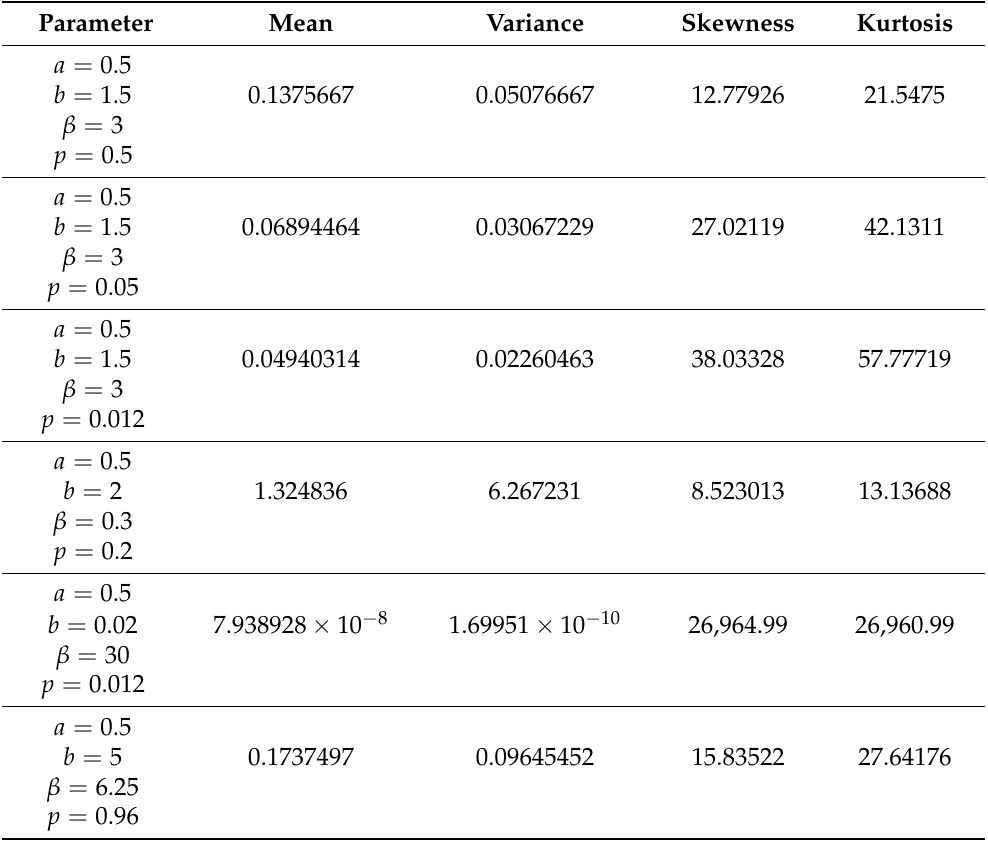
Table 1 indicates that, for fixed a , b and β , the mean and variance of the